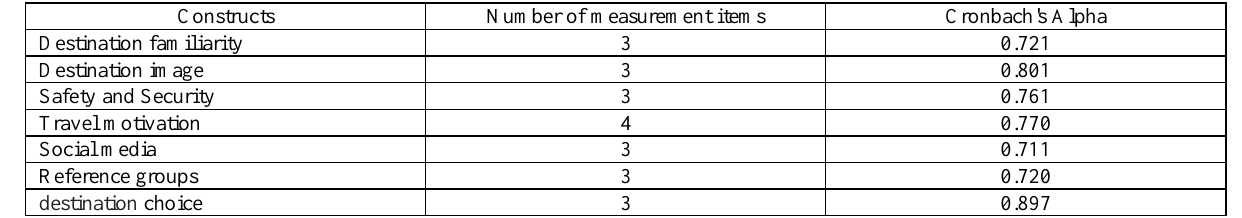
Table 4. Assessment of reliability